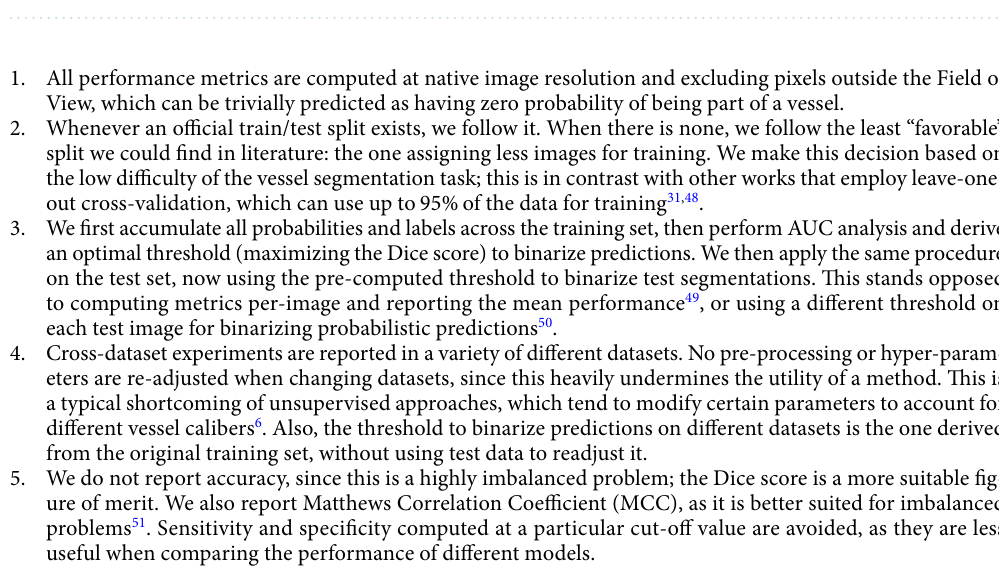
Table 1. Description of each of the ten datasets considered in this paper in terms of image and population